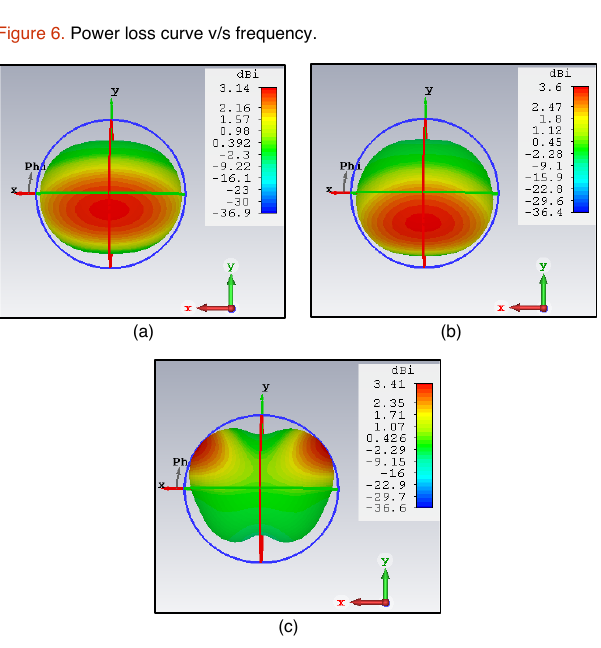
Figure 7. Directivity in dBi at (a) 2.4 GHz (b) 3.5 GHz (c) 5.5 GHz.